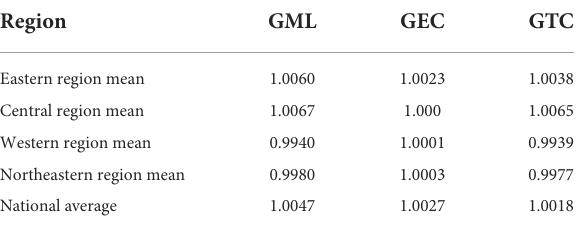
TABLE 4 The regional differences in the GML index of China’s pharmaceutical industry. Region GML GEC GTC Eastern region